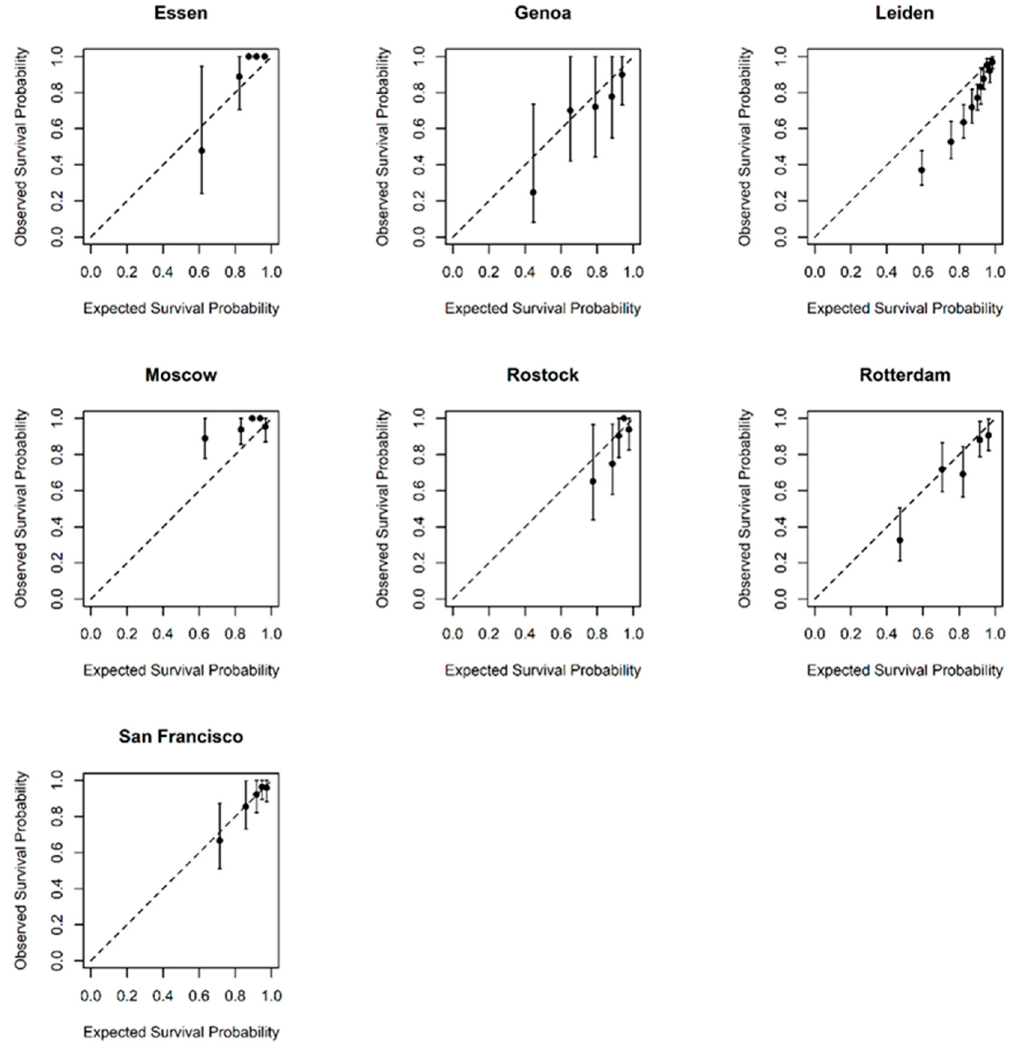
Figure 2. Calibration graphs comparing observed and predicted survival in each of the external datasets at 3 years post-treatment. Subjects were divided into five distinct prognostic groups according to their predicted survival and the average predicted survival for each group was plotted against observed survival. The dashed diagonal line is the line of equality and so markers along this line show perfect agreement between their predicted and observed